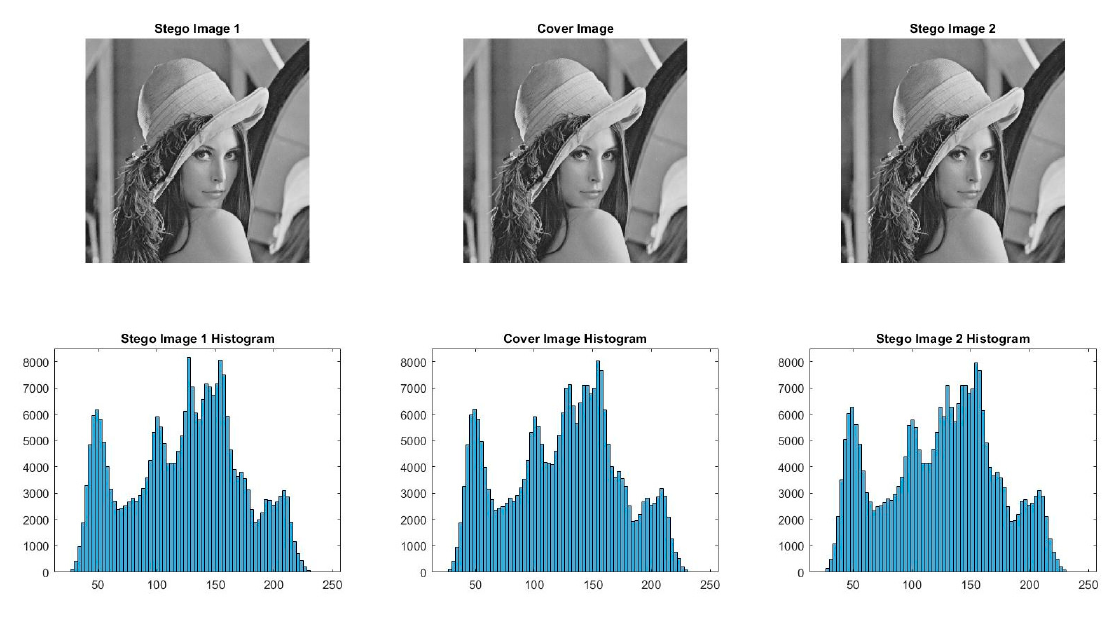
Figure 8. Comparisons of histogram analysis for n = 1 in grayscale Lena image.